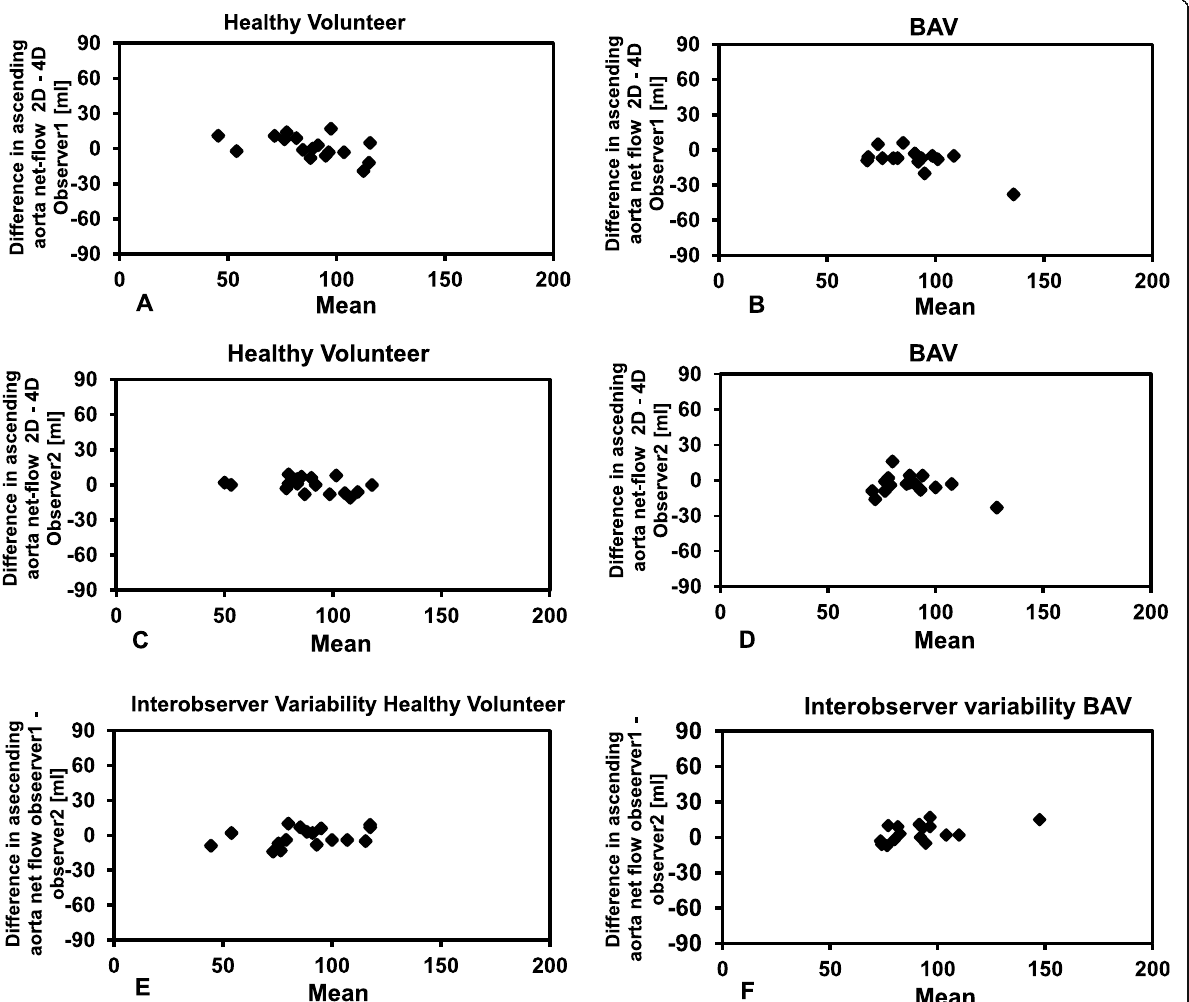
Fig. 4 Bland Altman plots: the Y -axis represents the individual differences of the ascending aorta net flow (ml) measurements by the two methods; two-dimensional (2D) and four-dimensional (4D) flow analysis by the two observers (upper two rows). In the lower row Y -axis represents the individual differences of the interobserver variability of the ascending aorta net flow measurements by the 4D method. X -axis represents the mean. Graphs a , c , and e represent healthy volunteers, and graphs b , d , and f represent patients with bicuspid aortic valve